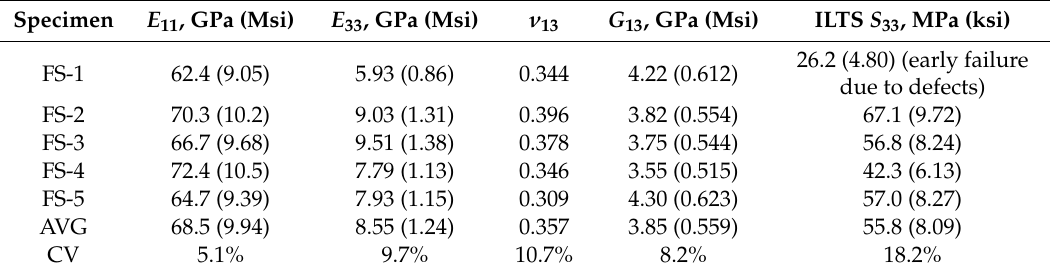
Table 2. Elastic constitutive properties and ILT strength for the carbon / epoxy fabric OHC-ILT specimens.